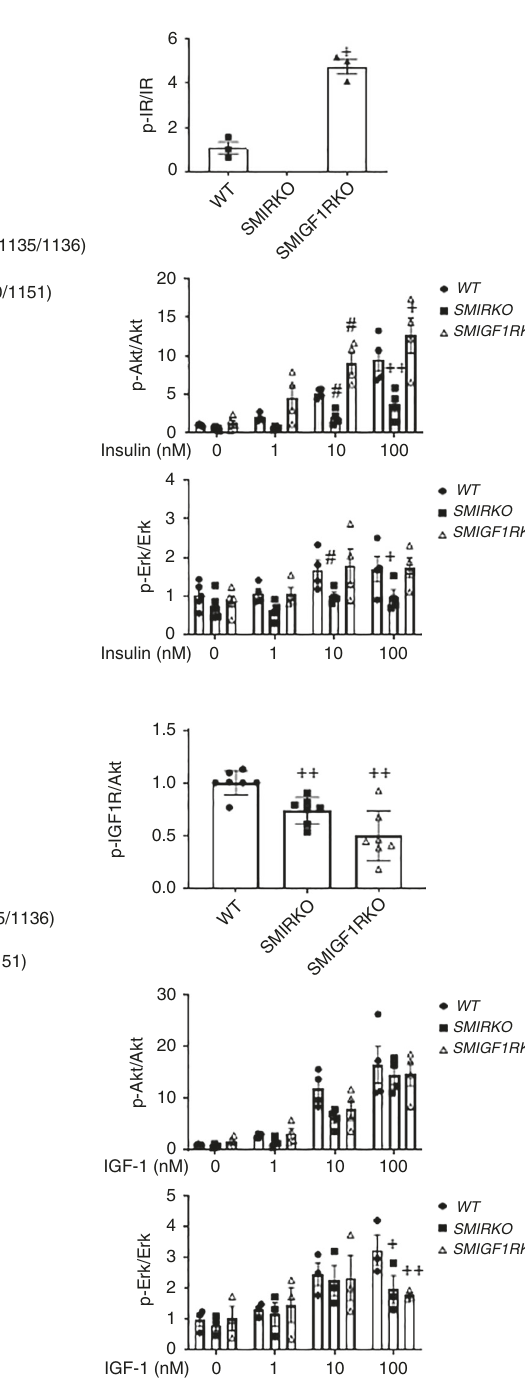
Fig. 3 Insulin and IGF-1 signaling in WT , SMIRKO, or SMIGF1RKO VSMCs. a Starved VSMCs were stimulated with different dose of insulin for 15 min (For pIR/IR, n = 3 for each group; for pAkt/Akt and pErk/Erk, n = 5 for each group at 0 nM; n = 4 for each group at 1, 10, and 100 nM. # p < 0.05, vs. WT stimulated with 10 nM inslulin; + p < 0.05, ++ p < 0.01 vs. WT stimulated with 100 nM insulin). b Starved VSMCs were stimulated with different dose of IGF-1 for 15 min (For pIR/IR, n = 7 for each group; for pAkt/Akt, n = 4 for each group and for pErk/Erk, n = 3 for each group, + p < 0.05, ++ p < 0.01 vs. WT stimulated with 100 nM IGF-1). The data are mean ± SEM. Two-tailed t test or two-way ANOVA with a post hoc test. Source data are provided as a Source Data fi IR and IGF1R deleted, either chimeric receptor IR-ECD/IGF1R- was increased by 1.7-fold compared with endogenous IGF1R β in ICD or IGF1R-ECD/IR-ICD was overexpressed using adenovirus WT VSMCs. IR β was increased by 13.7-fold in VSMCs vectors to mediate the infection. Both endogenous IGF1R β and overexpressing the chimeric IGF1R-ECD/IR-ICD compared with endogenous IR β in WT VSMCs. Insulin-induced p-Akt levels IR β expressions were decreased by >90% in VSMC with double were greater in IR-extracellular domain/IGF1R-intracellular knockdown of IR and IGF1R (Fig. 5a, b). In VSMCs over- domain VSMCs by 250% than IGF1R-extracellular domain/ expressed with IR-ECD/IGF1R-ICD, the amount of the IGF1R β